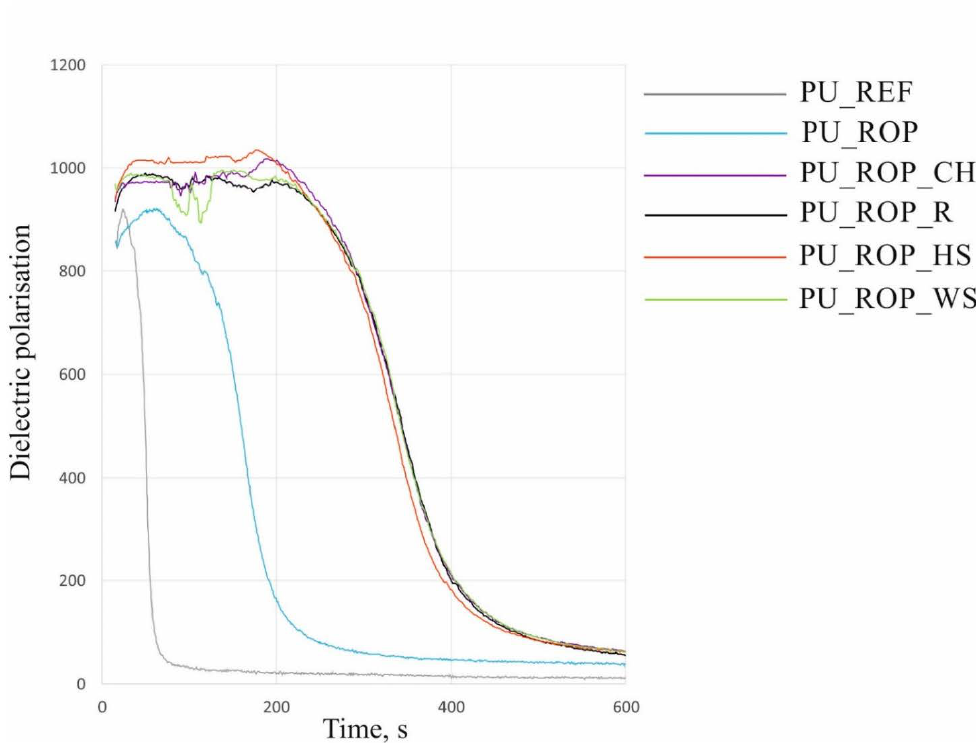
Figure 5. The influence of the ROP and natural fillers on the dielectric polarization during the foaming